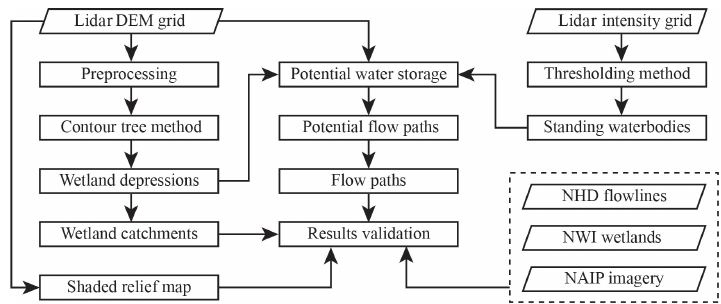
Figure 3. Flowchart of the methodology for delineating wetland catchments and flow